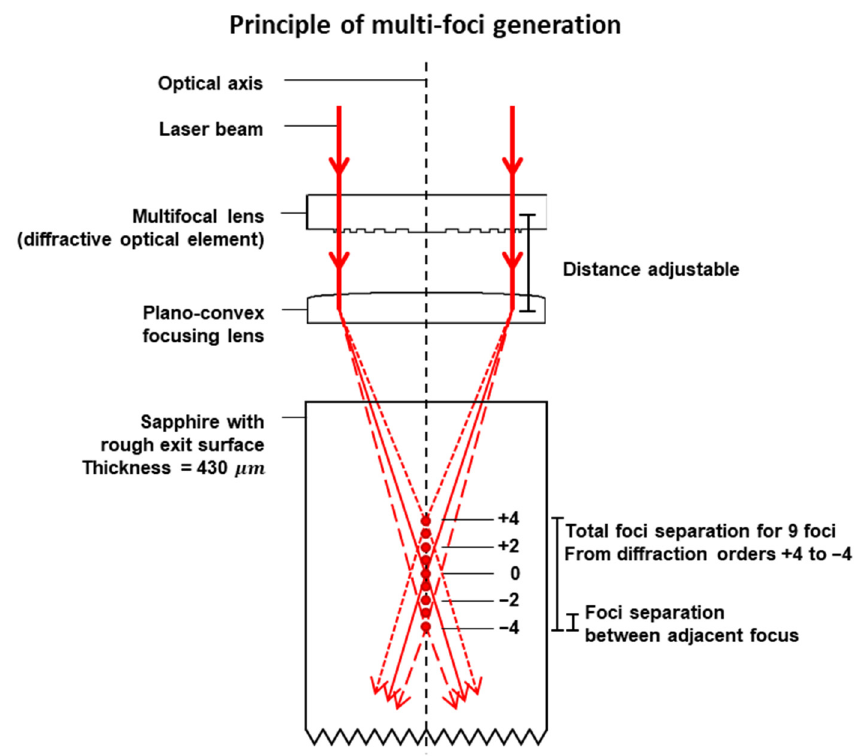
Figure 1. Schematic of 9-foci generation within the sapphire sample.